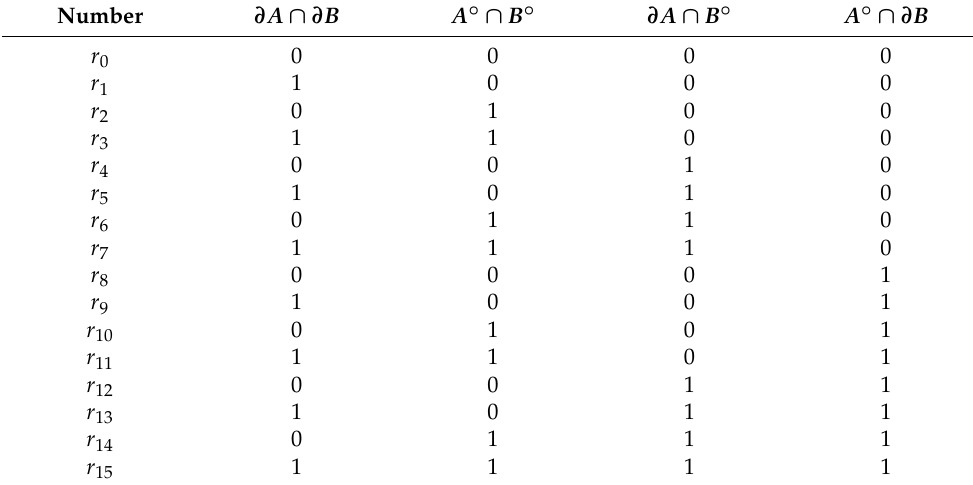
Table 2. The sixteen possible topological spatial relations between the closed sets A and B .